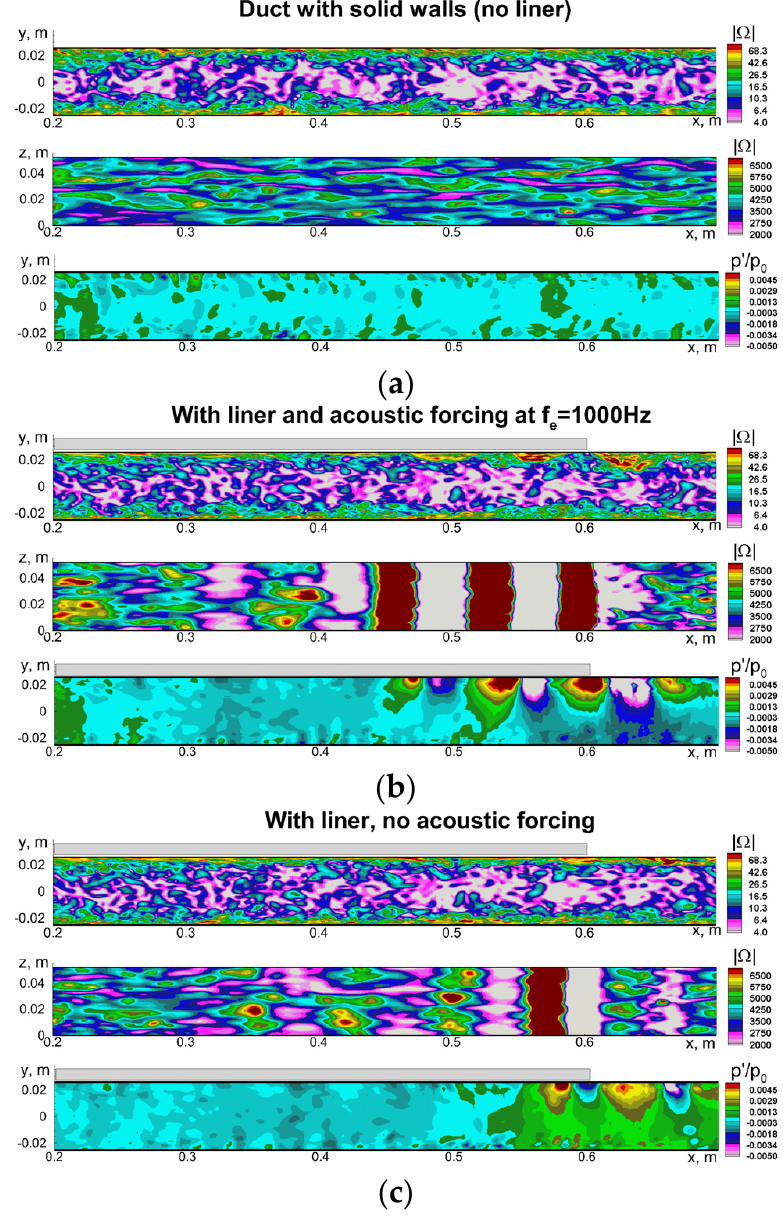
Figure 1. WMLES predictions [13] of the effect of liner and acoustic forcing on instantaneous fields of vorticity magnitude in a meridian plane and at the upper (lined) wall and pressure fluctuations in a meridian plane of NASA GIT [14] (liner shown by grey rectangular is located at 0.2 m < x < 0.61 m). ( a ): flow in solid-wall duct (no liner); ( b ): flow in duct with liner and acoustic forcing at f e = 1000 Hz; ( c ): flow in duct with liner without any external forcing.